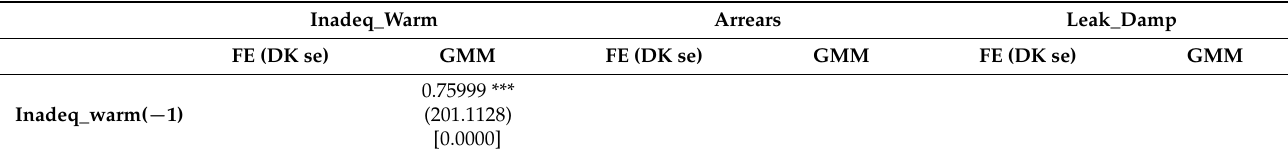
Table 6. Regression results with three different dependent